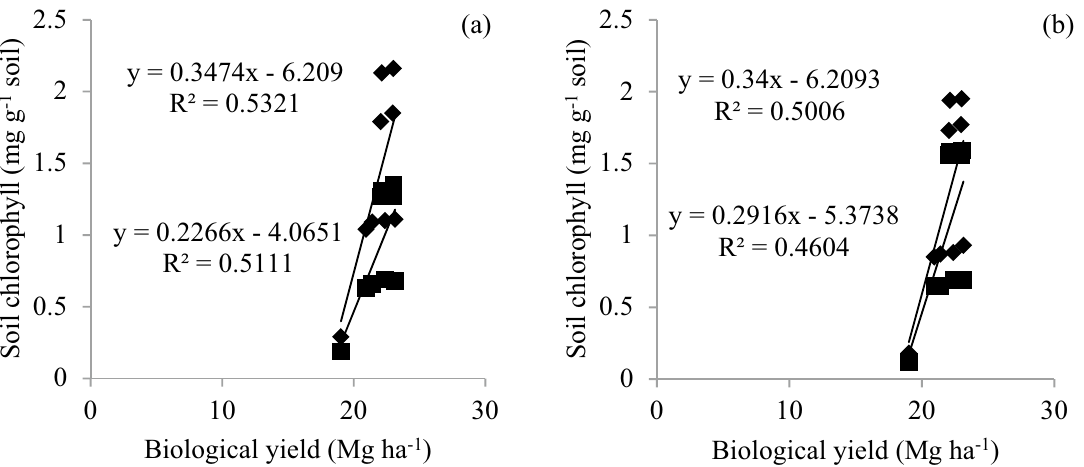
Figure 2. Correlation between biological yield and soil chlorophyll in rice ( a ) at 70 days after sowing in 2013 (◆) and 2014 ( ■ ) (DAS) and wheat ( b ) at 60 DAS in 2013–2014 (◆) and 2014–2015 ( ■ ).